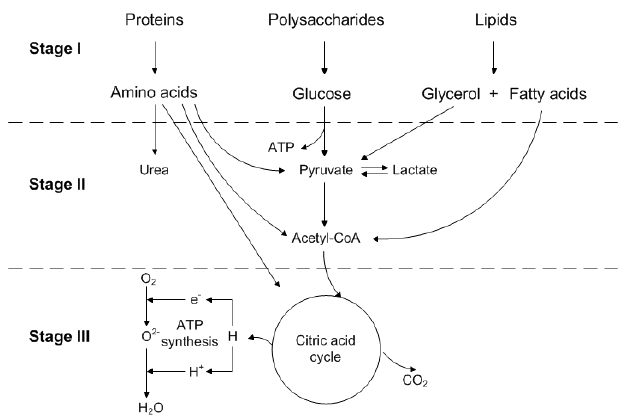
Figure 2. Schematic overview of the main catabolic metabolism divided into three stages, adapted from [32].